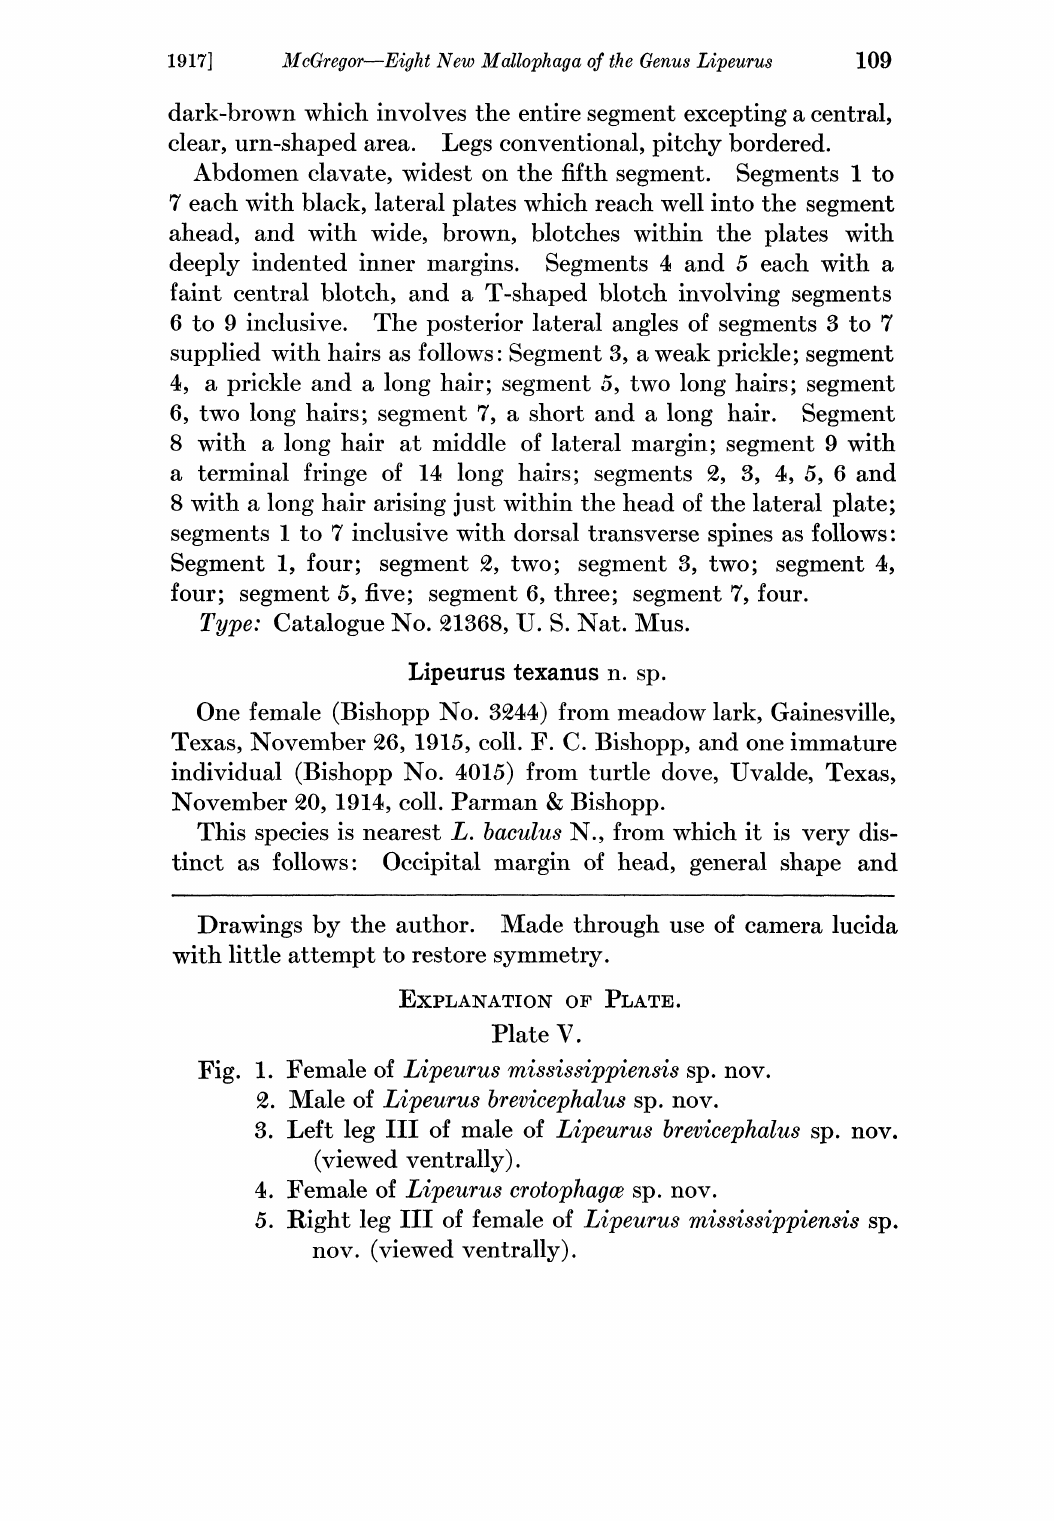
. Fig. 1. Female of Lipeurus mississippiensis sp. nov. Male of Lipeurus brevicephalus sp. nov.